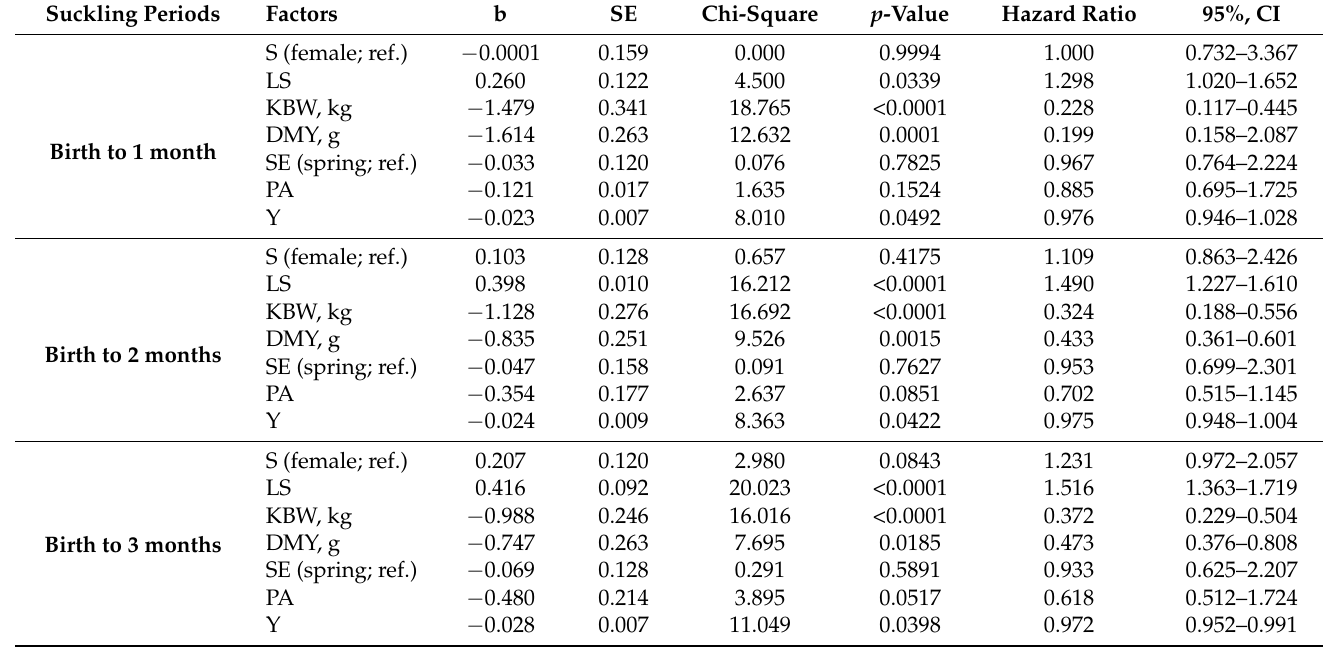
Table 4. Analysis of maximum likelihood estimates for different potential risk factors affecting the survivability of Zaraibi kids during suckling